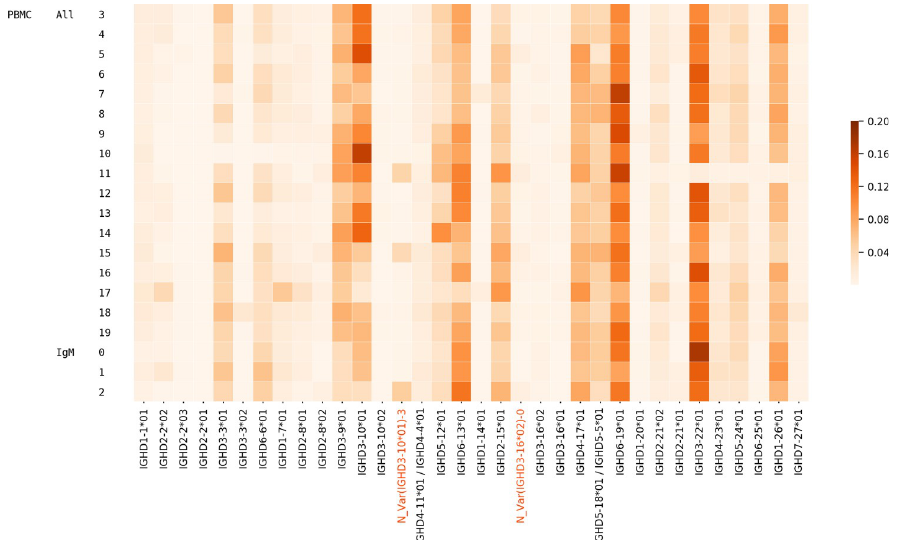
Fig 4. Usage of various known and novel genes in various Healthy datasets. Each row corresponds to a different dataset described by the three leftmost columns. The first column denotes the tissue, i.e., PBMC, the second column denotes the isotype (IgM or all/unsorted), and the numbers in the third column represent different individuals. The color in each cell represents the proportion of traceable CDR3s that were formed by a gene on the x-axis in the dataset corresponding to the y-axis. Validated novel variations are highlighted on the